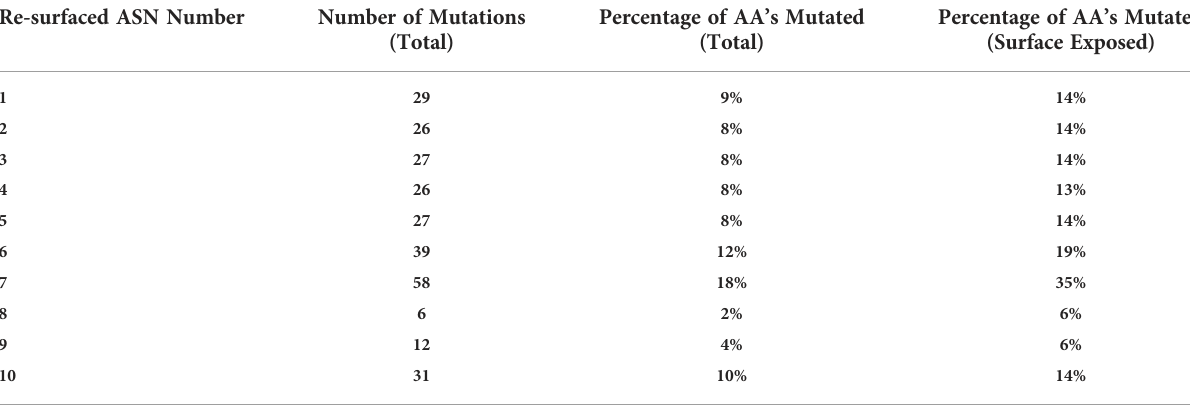
TABLE 1 Mutational distance and percent homology for Re-surfaced ASN candidates.